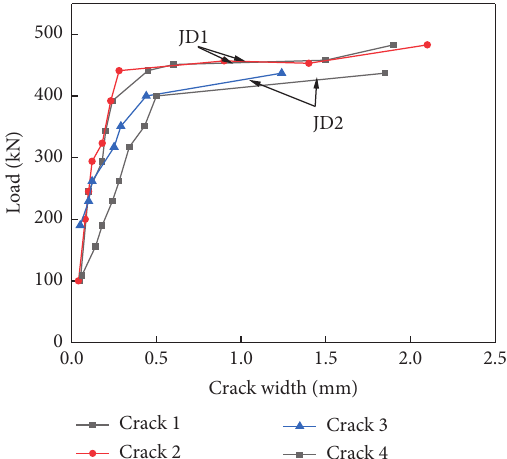
Figure 14: Load-crack width curves of JD1 and JD2 beams.